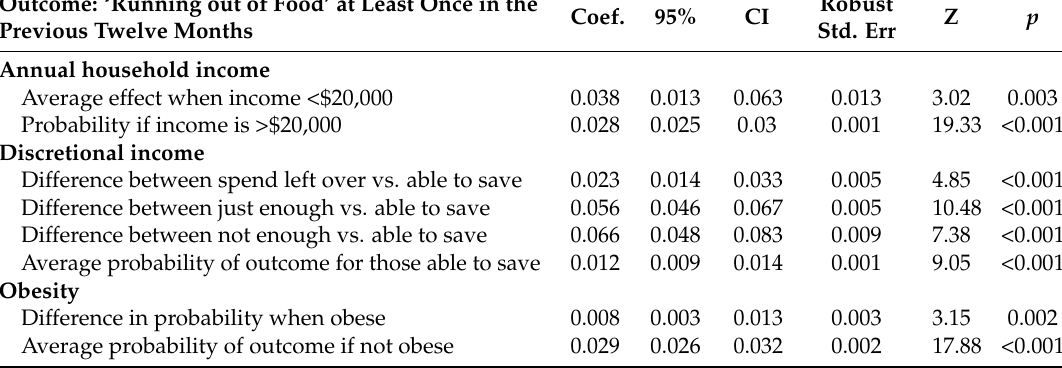
Table 3. Estimate of probability of food insecurity (‘running out of food’ and not being able to afford more) by income, discretional income and obesity, adjusted using propensity scores: Showing probable antecedent factors of ‘running out of food’, HWSS